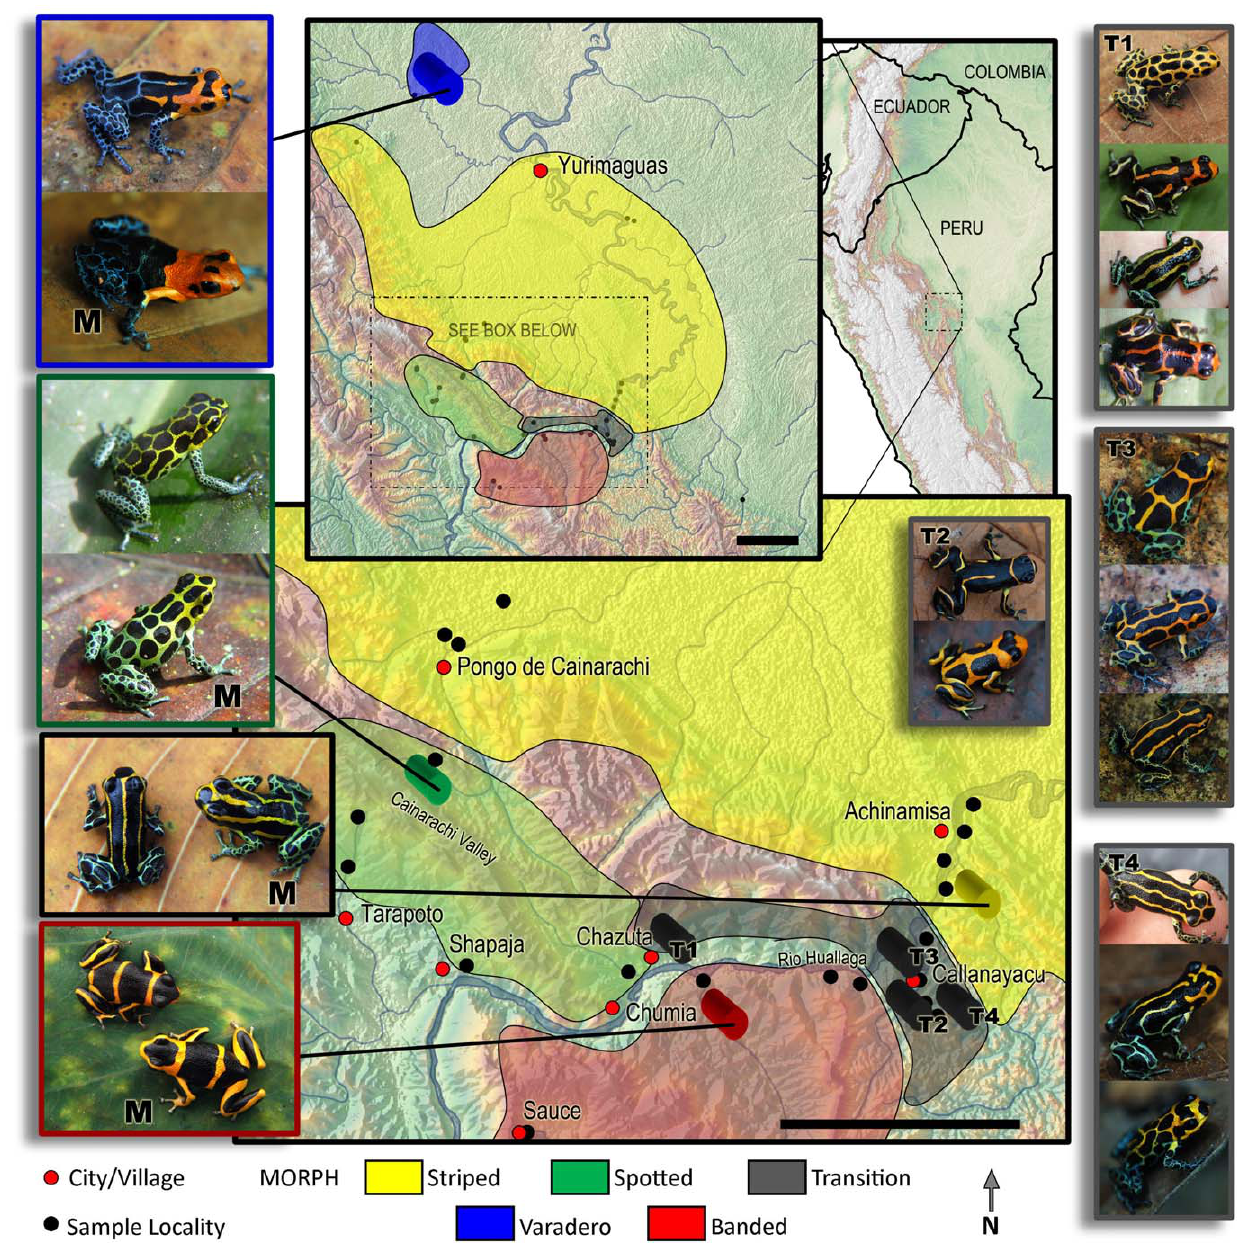
Figure 1. Map showing the four main color patterns and their putative models (left) and highly variable populations (right), in San Martin and Loreto provinces, Peru. Photos on left-hand side show the four mimetic morphs of R. imitator and corresponding model species (denoted with ‘‘M’’). Photos on right-hand side give examples of four transition zones (T1–T4) Black scale bars=30 km. doi:10.1371/journal.pone.0055443.g001 On this basis, we classified localities into populations using three criteria: the first results from STRUCTURE (placing Sauce and Varadero into separate populations); color pattern morph (spotted, banded, striped, the Varadero morph, and two intermediate morphs: Chazuta (spotted/banded) and Callanayacu (banded/ striped)); and distance (two widely separated localities of the same color pattern morph were designated as distinct populations: Chumia/Shapaja and Tarapoto/Cainarachi Valley; Ricardo Palma/Aguas Termales/Achinamisa and Pongo). In order to maximize the potential to detect genetic differentiation among putative populations, we removed samples from the dataset that